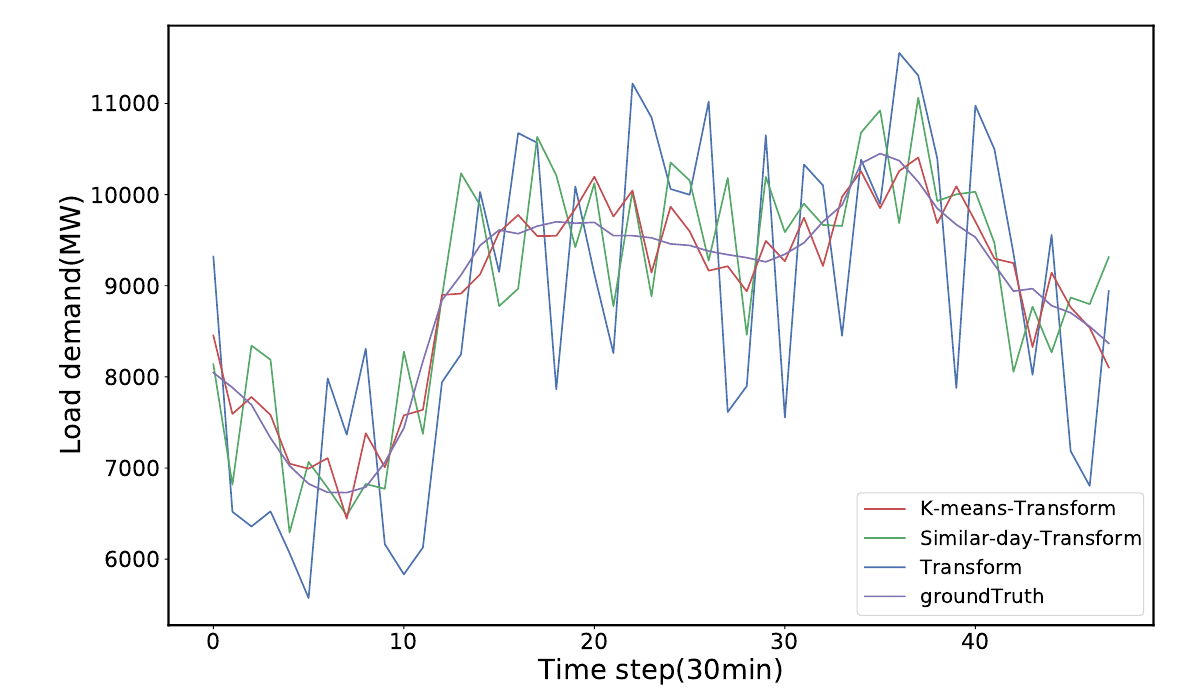
Figure 11. Day-ahead prediction of various model (date 2 September